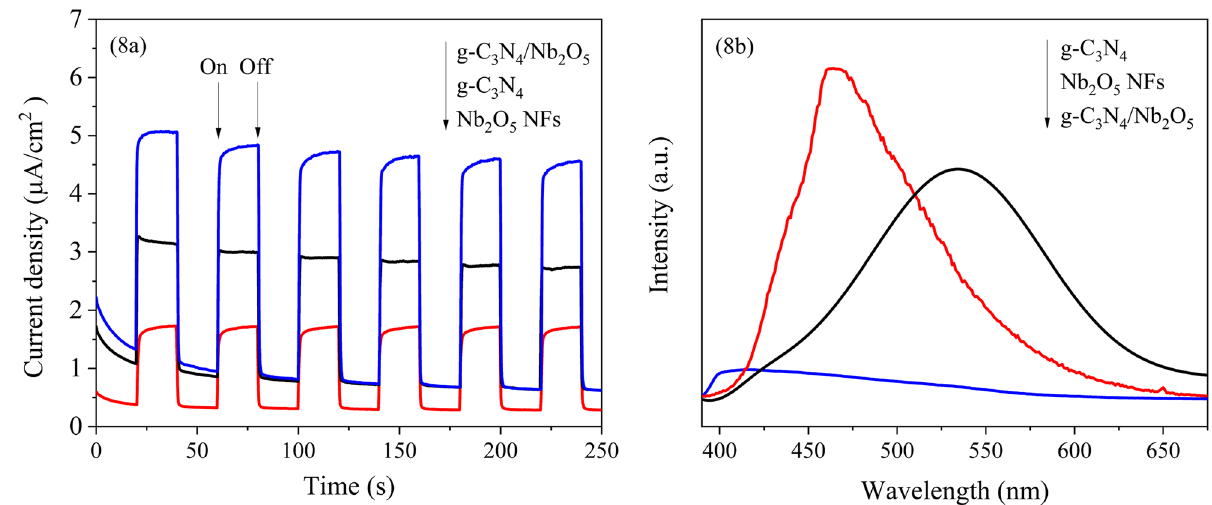
Figure 8. ( a ) Transient photocurrent response and ( b ) PL spectra of g-C 3 N 4 , Nb 2 O 5 NFs and g-C 3 N 4 /Nb 2 O 5